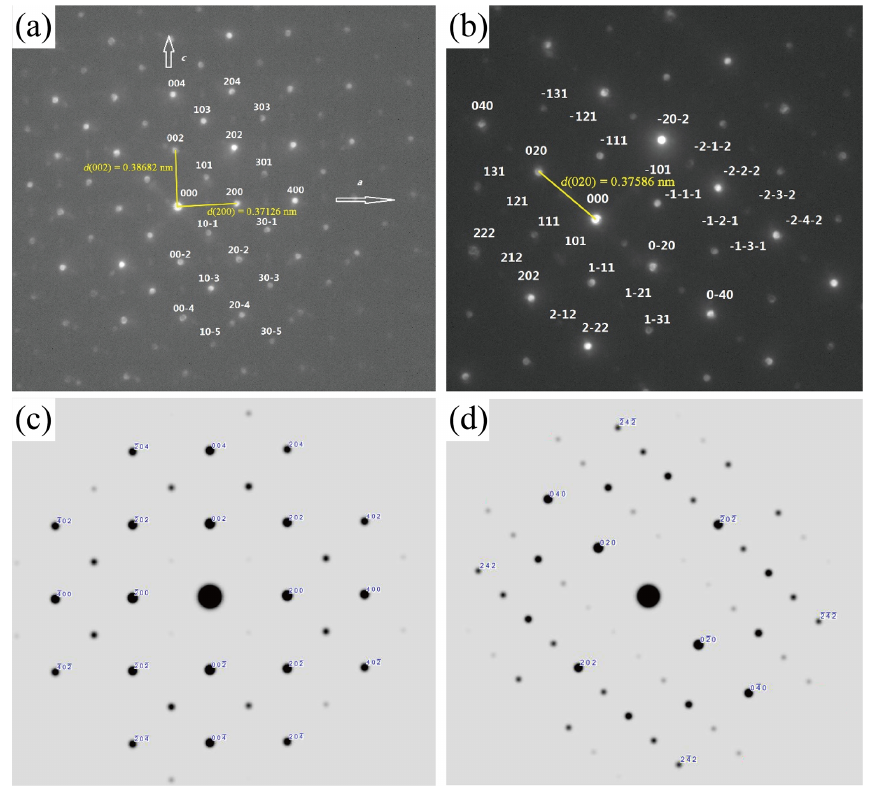
Figure 10. Selected area electron diffraction (SAED) patterns and calculated patterns for liguowuite; (a) [010] zone axis electron diffraction pattern and indexation of the liguowuite structure (the reflection condition of glide plane n is h + l = 2 n ( k = 0); weak extra h + l (cid:54)= 2 n reflections are marked in light blue.); (b) [10–1] zone axis electron diffraction pattern and indexation of the liguowuite structure; (c) [010] zone axis electron diffraction simulation calculated using the P 2 1 /n model; (d) [10–1] zone axis electron diffraction simulation calculated using the P 2 1 /n model.